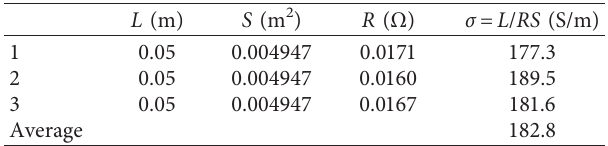
Figure 9: Relationship between voltage drop at both ends of the probe and current (plane direction). Table 1: Electrical conductivity data of the carbon/carbon fiber composite (perpendicular to the plane direction).